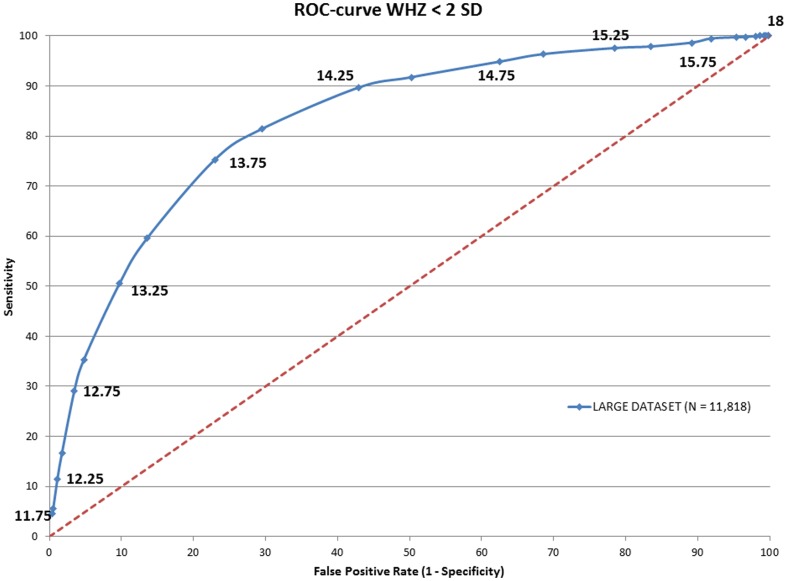
ROC curve of the MUAC score in against WHZ<-2SD.